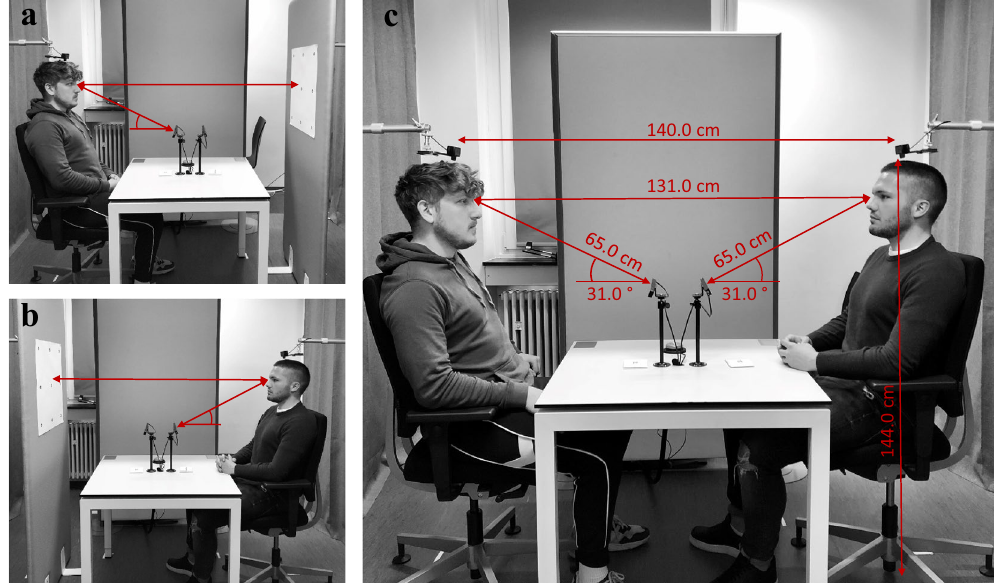
Figure 1. Dual eye-tracking calibration procedure and setup. Shown are experimental setups and relevant distances during the calibration procedure for participant A ( a ), participant B ( b ), and the face-to-face interaction between both participants ( c ). Distances are given in cm and angles are given in degree. Participant A (randomly picked) was taken to the experimental room and seated on a chair facing a calibration wall.